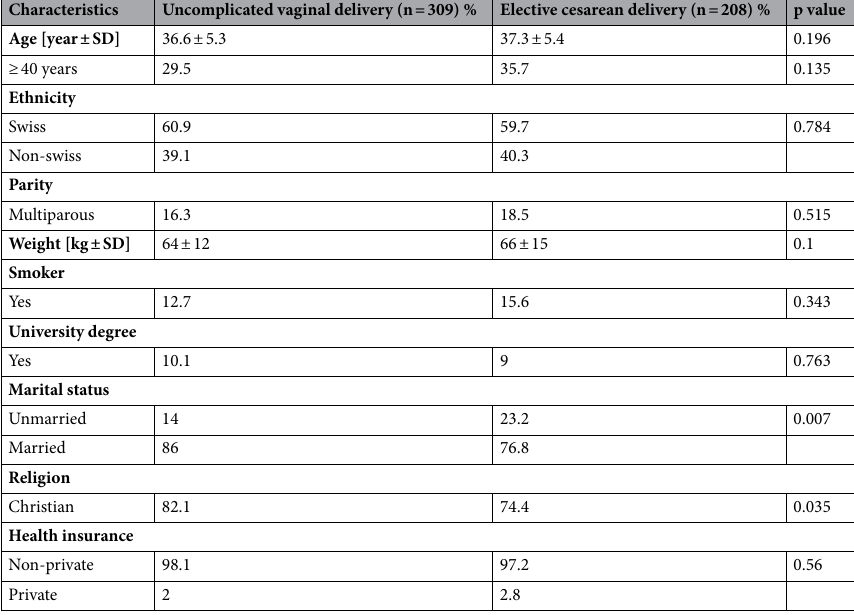
Table 1. Socio-demographic and physical characteristics of patients at the time of questionnaire completion. Data are shown as percentage of the total of each group, except for age and weight. SD standard